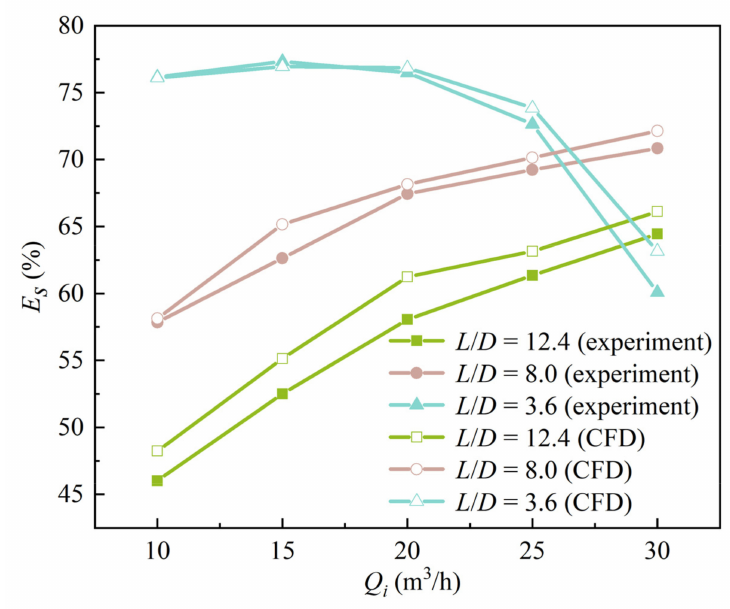
Figure 4. Separation Efficiency of Experiment and CFD